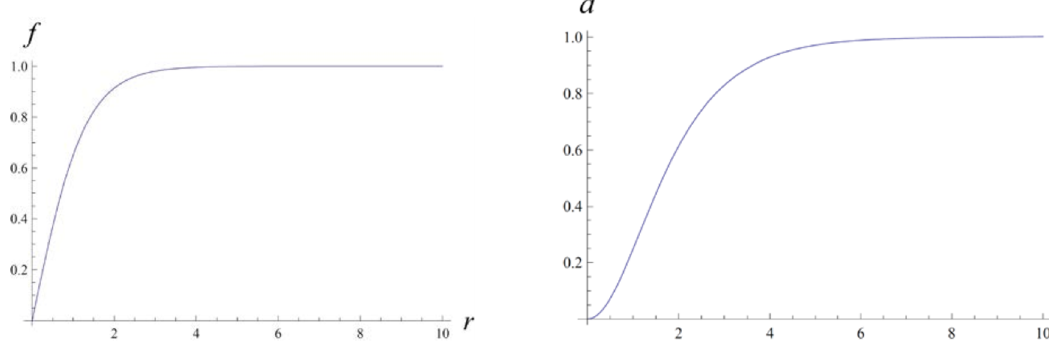
Figure 6 . Vortex with no gravity in a fixed Minkowski spacetime. The profiles of f and a are used to evaluate the mass.